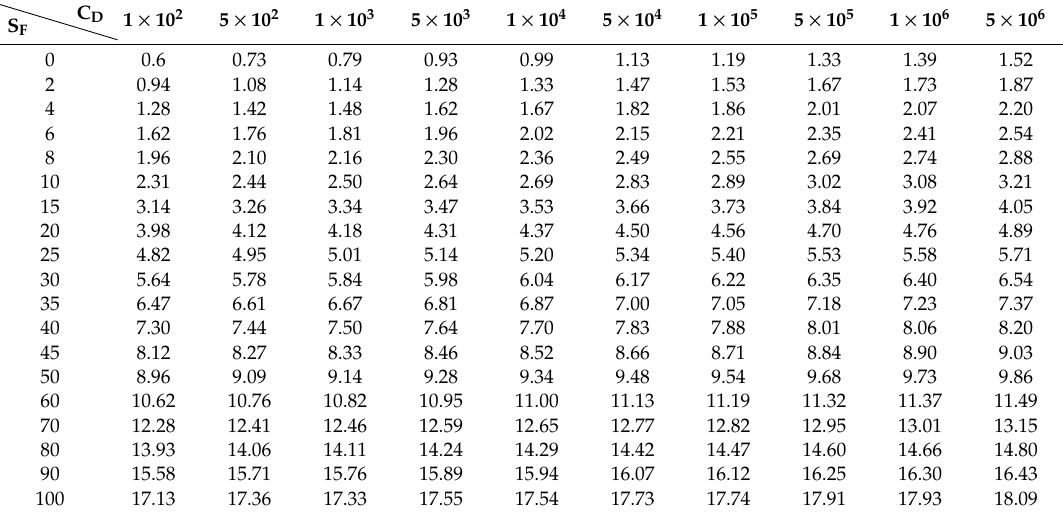
Table 1. Dimensionless drawdown, s D *, for the selected skin factors, S F, and the dimensionless wellbore storage, C D .